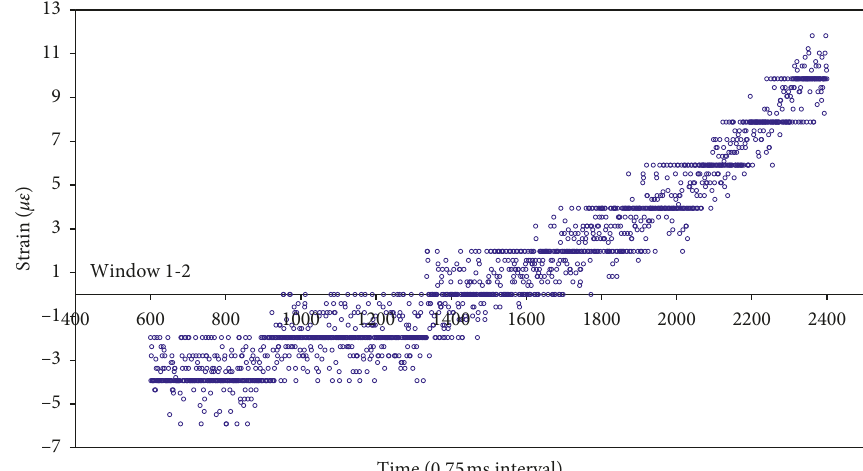
Figure 13: Vibration and temperature increase phase of the first